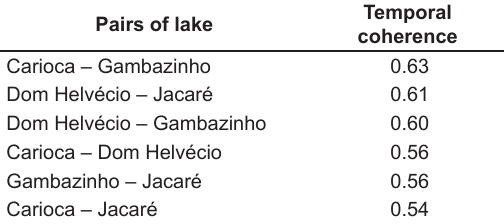
Table 6. Temporal coherence recorded for the lake pairs.